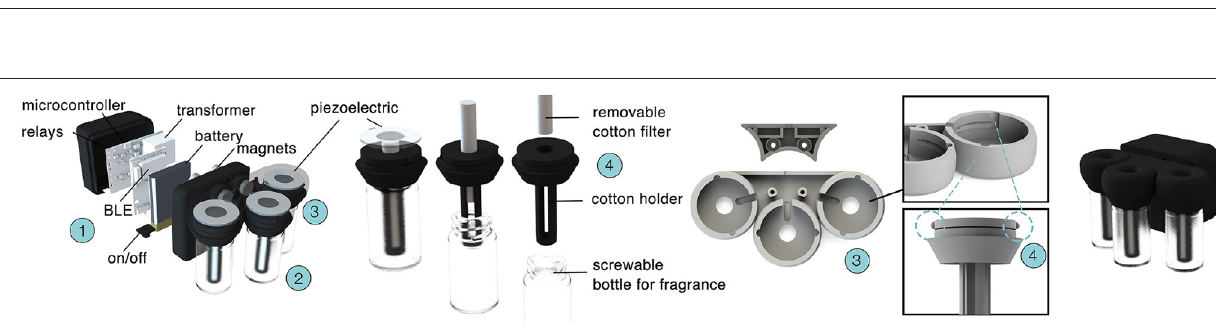
for this article with data from 20 participants (the training-set is 40 nights in total). The Tensorflow Lite model was imported to the Android App, and a UI was created to let the user pick at what sleep stage scent should be released. When the toggle is activated, the previously set intensity and frequency will be active, and the scent will be released when the accuracy of the predicted sleep stage is over